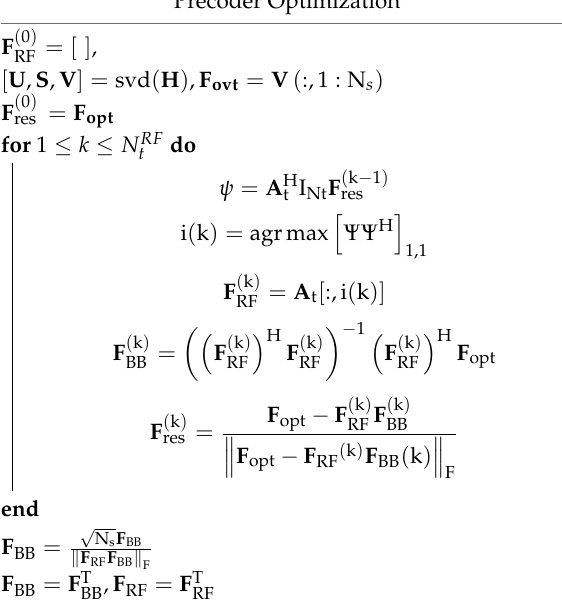
Algorithm 1. Proposed Extended SOMP